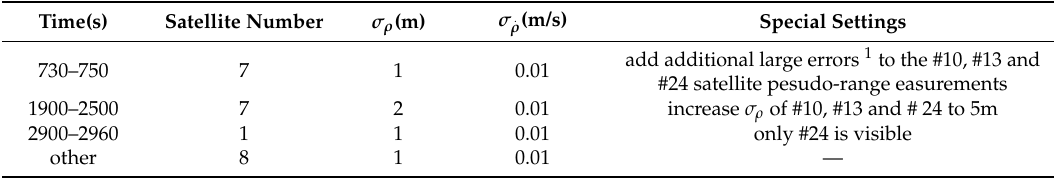
Table 2. The GNSS measurement error settings.